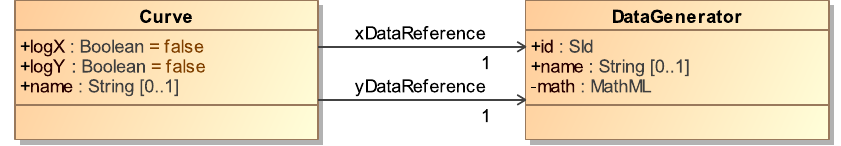
Figure 2.43: The SED-ML Curve class